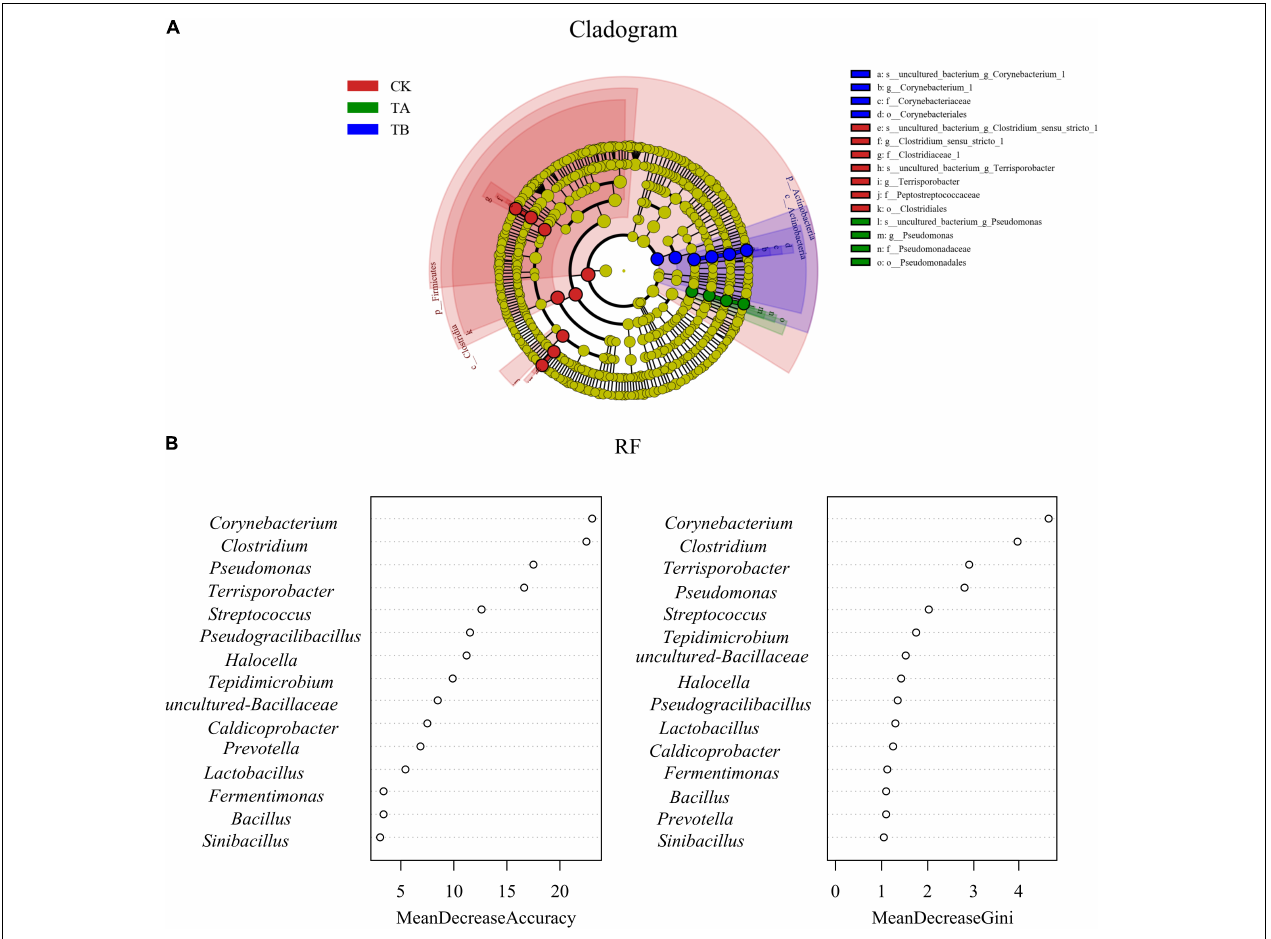
FIGURE 6 | (A) Bacterial taxa significantly differentiated between three different treatments identified by linear discriminant analysis effect size (LEfSe) using the default parameters. Bacterial taxa that were differentially abundant in different groups visualized in a cladogram. (B) Bacterial taxa significantly differentiated between the three different treatments using random